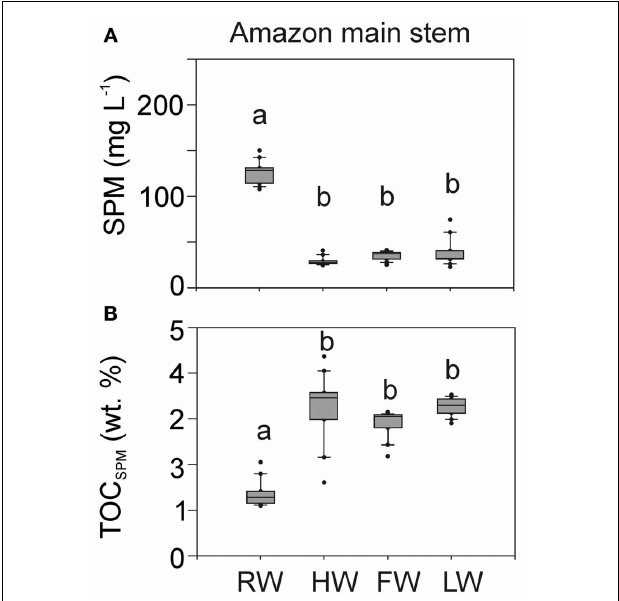
FIGURE 4 | SPM concentration (A) and TOC content of SPM in wt.% (B) in the Amazon main stem (Solimões and stations Amazon 1–4). Letters indicate statistically significant groups of data ( p < 0 . 05).